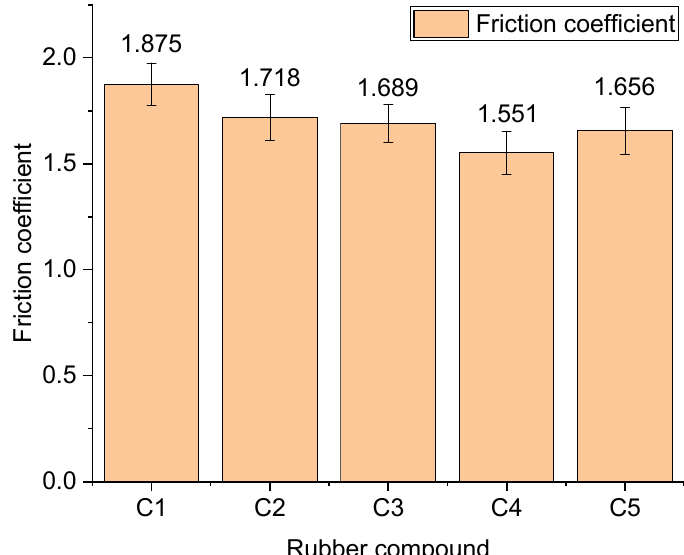
Figure 9. Average friction coefficient.